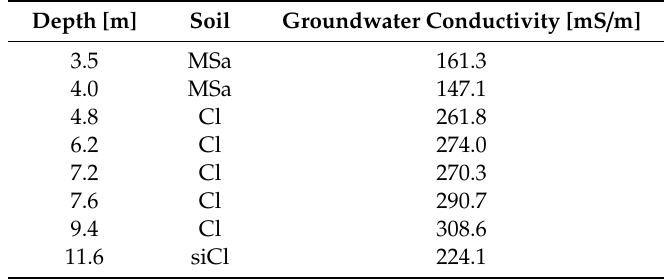
Table 3. Results of groundwater electrical conductivity measurements.